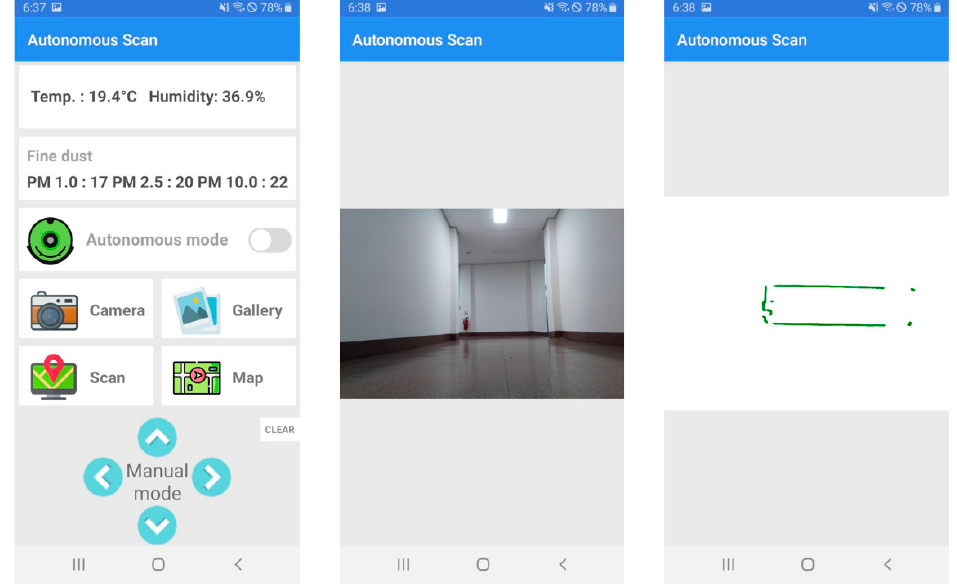
Figure 25. Environmental data result ( left ), captured image ( middle ) and scanned result ( right ) at initial position from which second autonomous scanning experiment was performed.